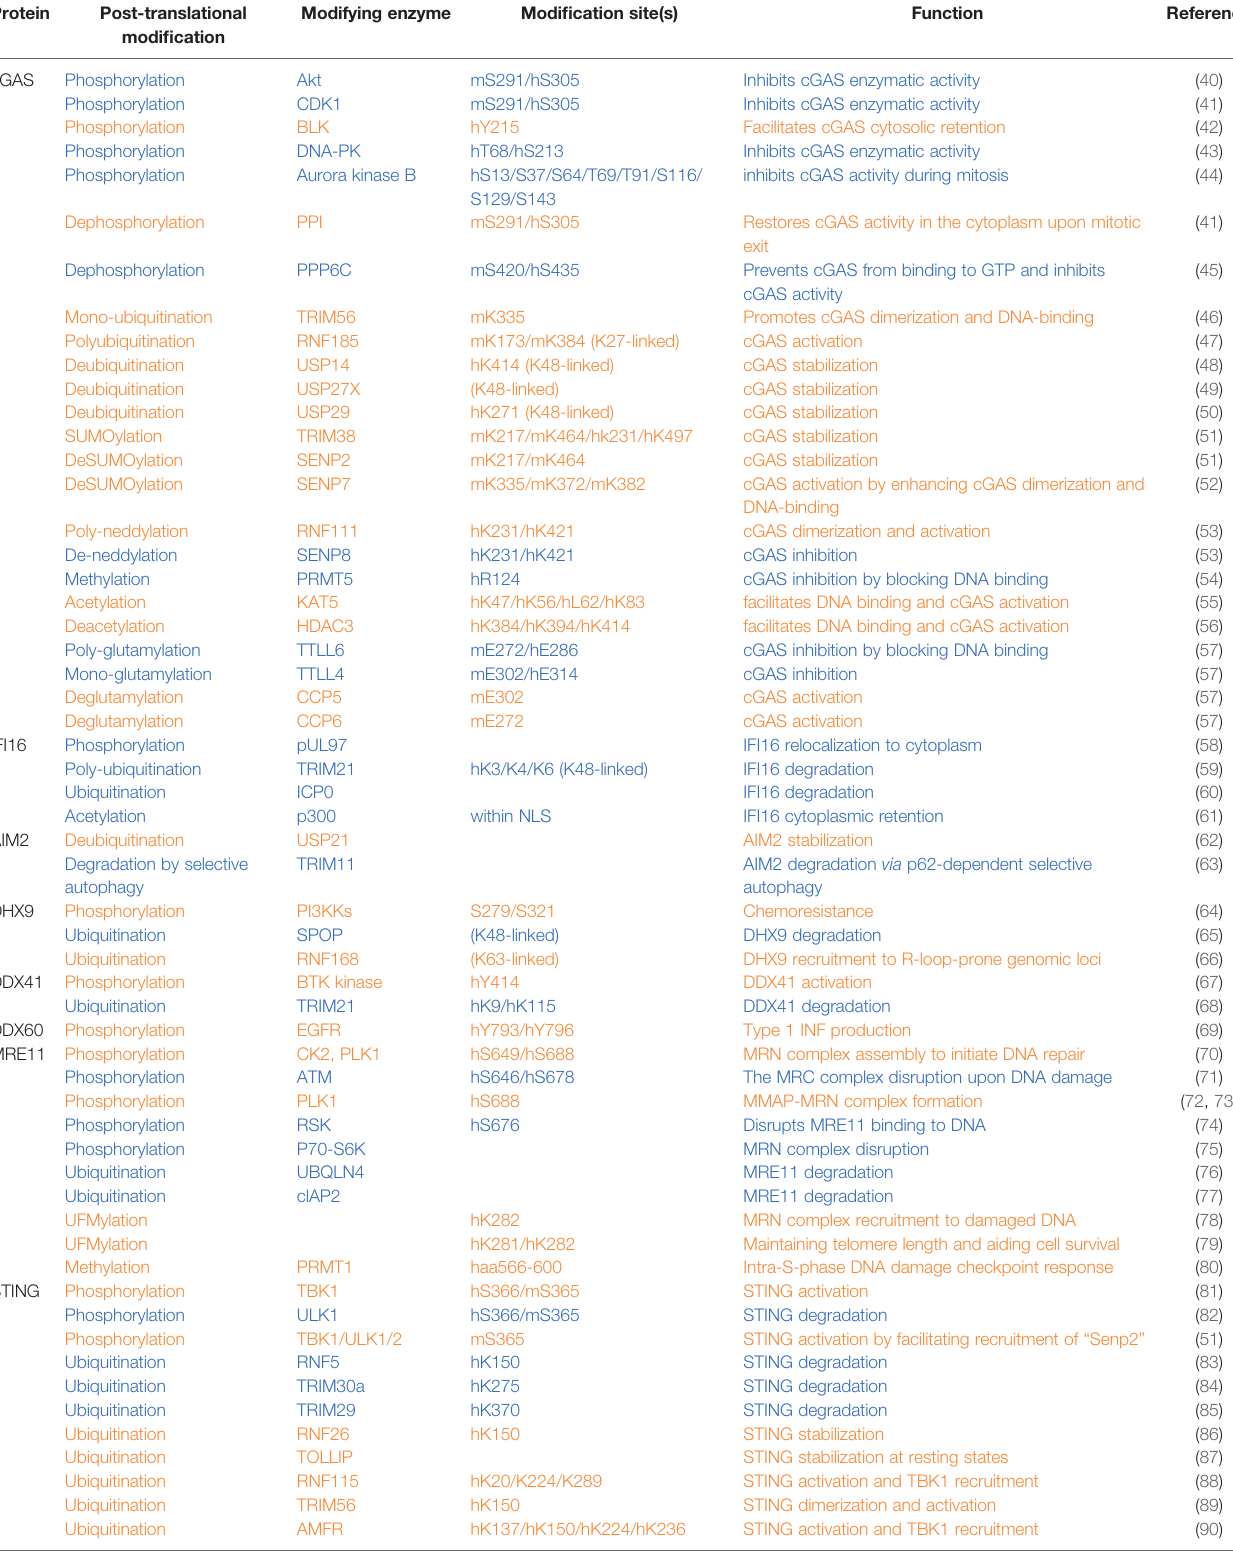
TABLE 1 | Post-translational modi fi cations of proteins in cytosolic DNA sensing signaling pathways.